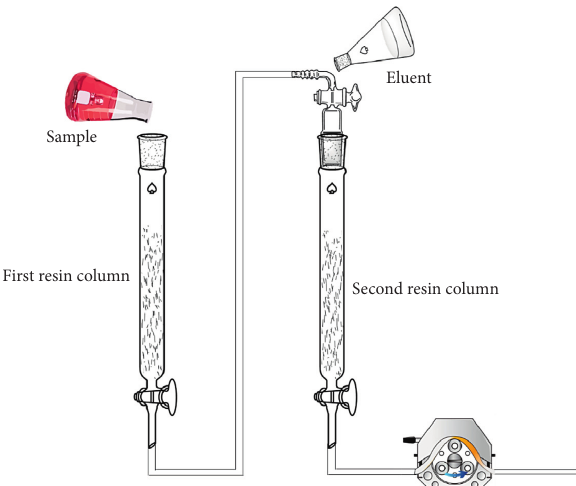
Figure 3: The schematic figure of macroporous resin columns in-